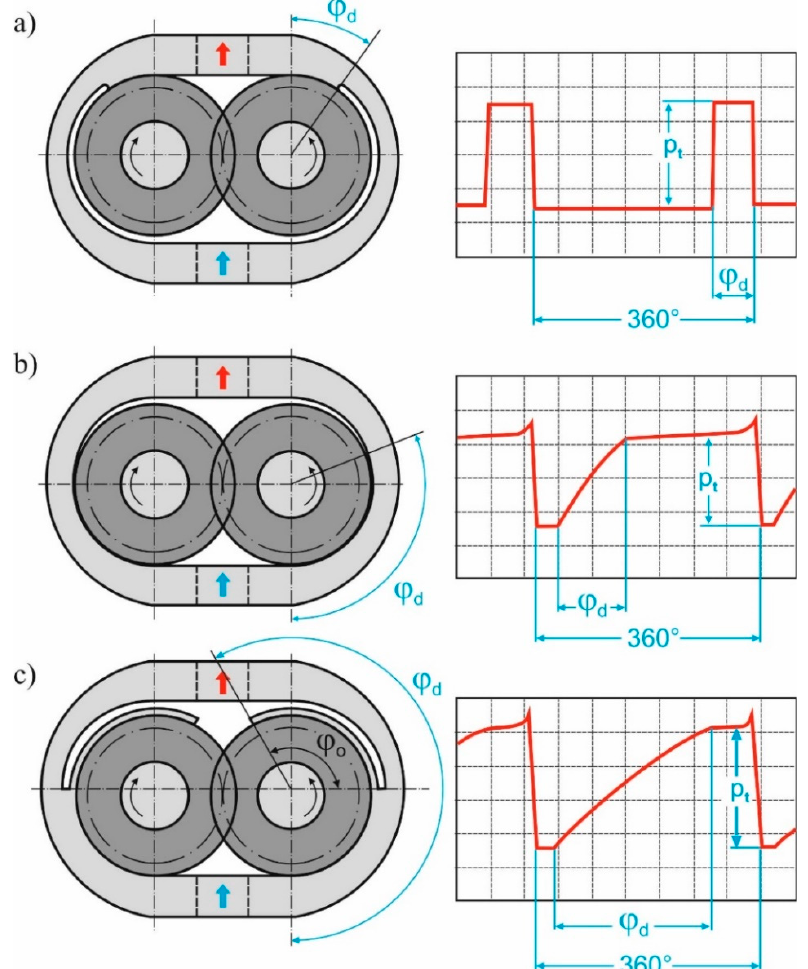
Figure 1. Schematic diagram of circumferential gear sealing together with the changes in the circumferential pressure measured in the tooth space as a function of the rotation angle of the gear: ( a ) pump with radial backlash compensation, ( b ) pump with gears shifted from the hydrostatic pressure of the liquid, ( c ) pump with circumferential backlash compensation. Indications: φ o —wrapping angle, φ d— caulk angle, p t —discharge (output) pressure [10].